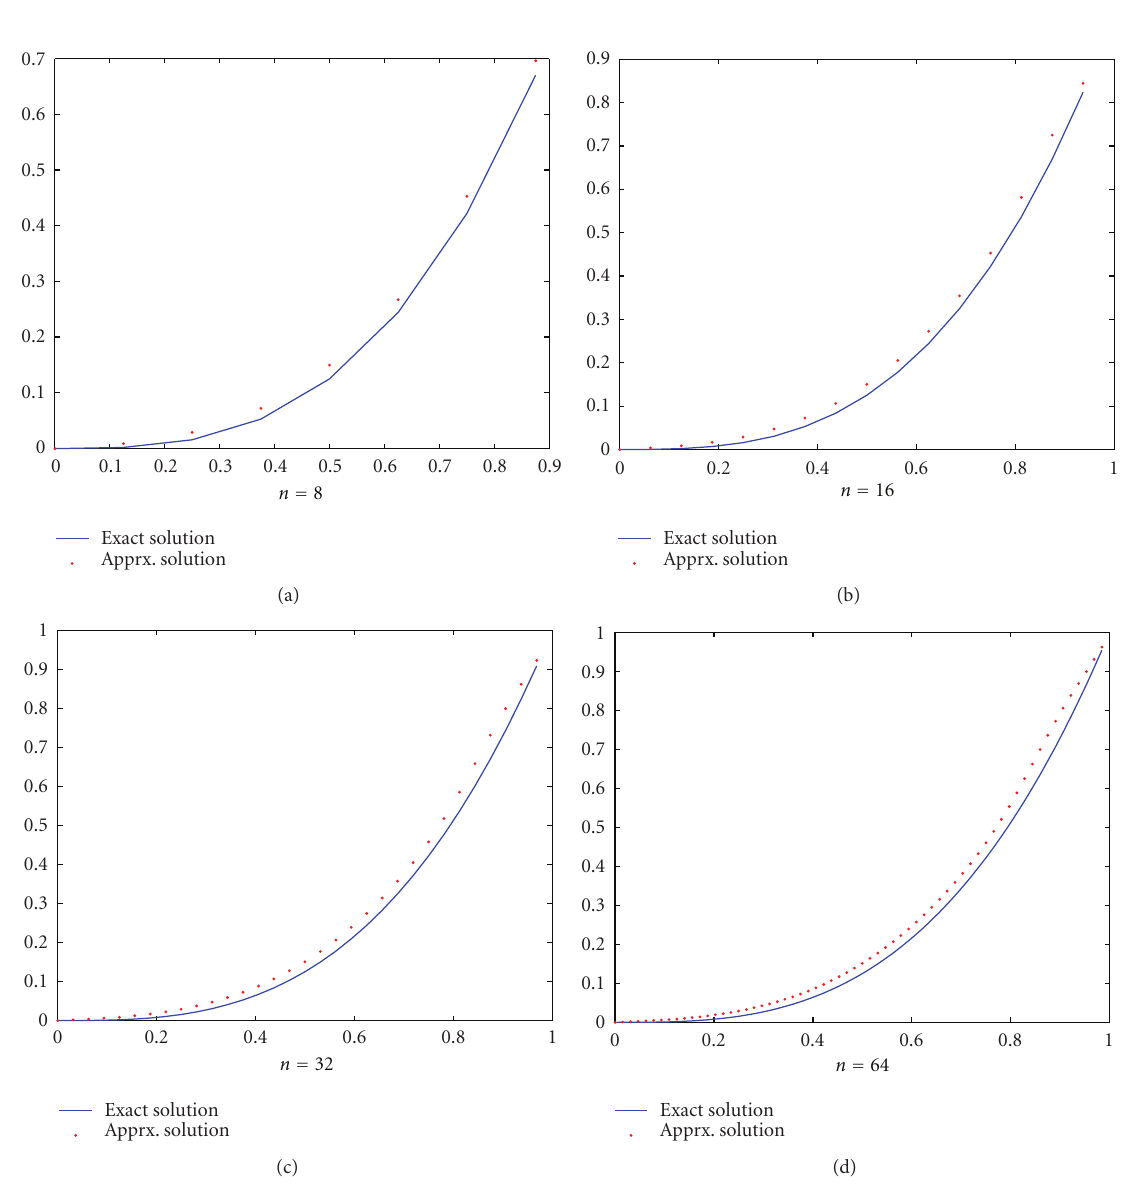
Figure 1: Curves of the exact and approximate